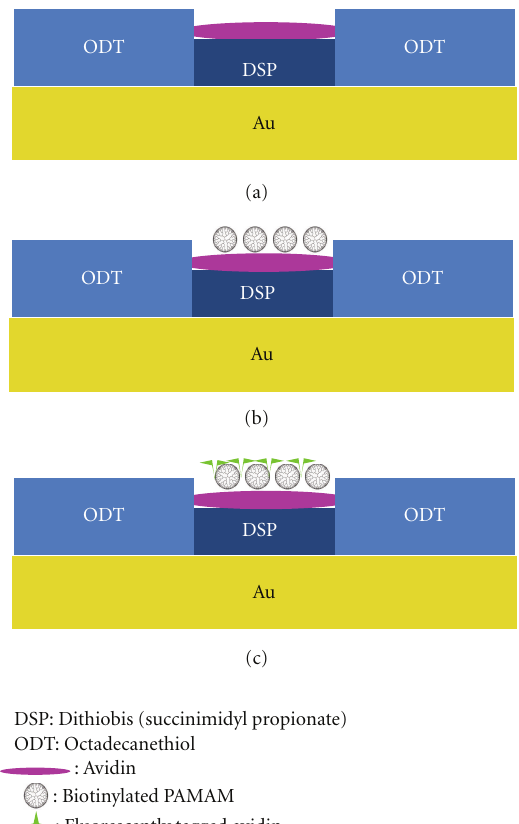
Figure 1: Schematic of capture assay platform: (a) immobilize avidin onto Au substrate with controlled surface area using DSP and (b) expose substrate to biotinylated PAMAM dendrimers. (c) The captured biotinylated PAMAM dendrimers can be fluorescently labeled for additional verification of immobilization and patterning of